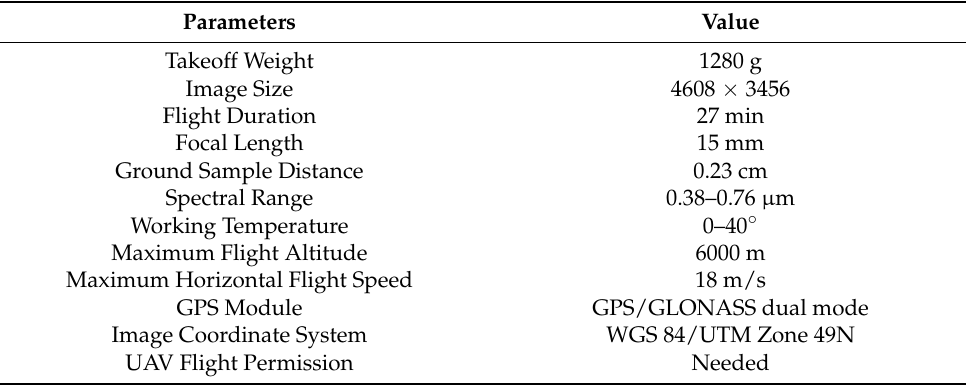
Table 1. Detailed information on the UAV